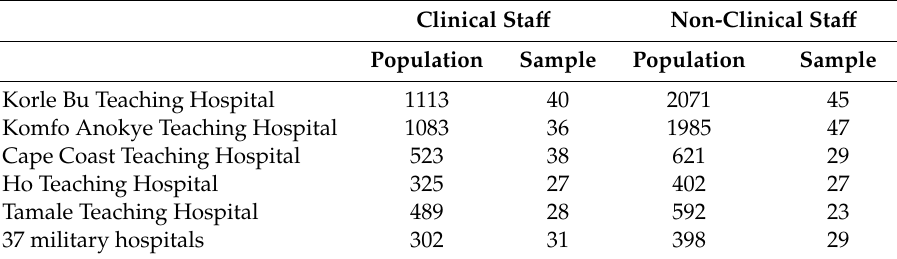
Table 1. Profile of respondents from respective